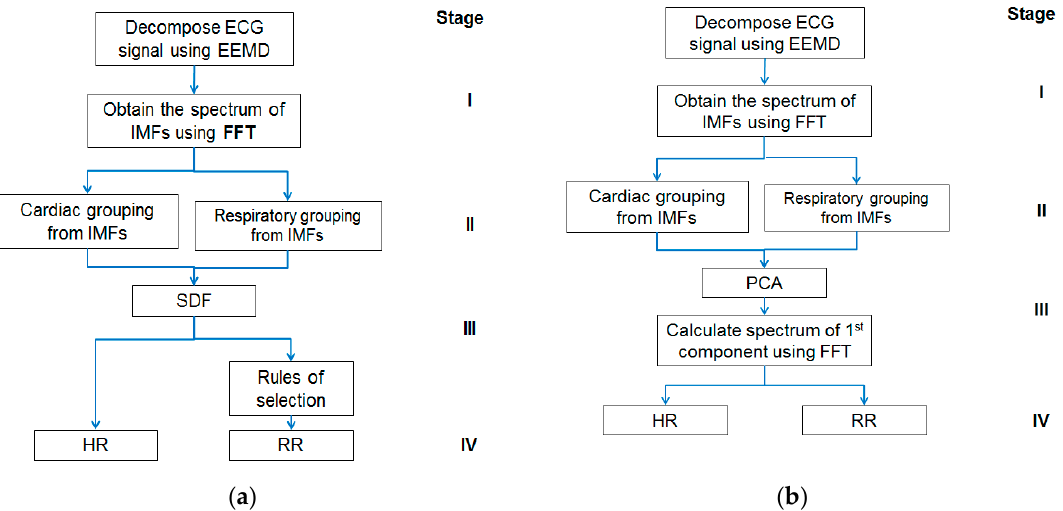
Figure 1. ( a ) The block diagram of the ensemble empirical mode decomposition with spectral data fusion (EEMD-SDF) method; ( b ) the block diagram of the ensemble empirical mode decomposition with principal component analysis (EEMD-PCA) method. FFT, Fast Fourier Transform; RR, respiratory rate; HR, heart rate; IMF, intrinsic mode function.